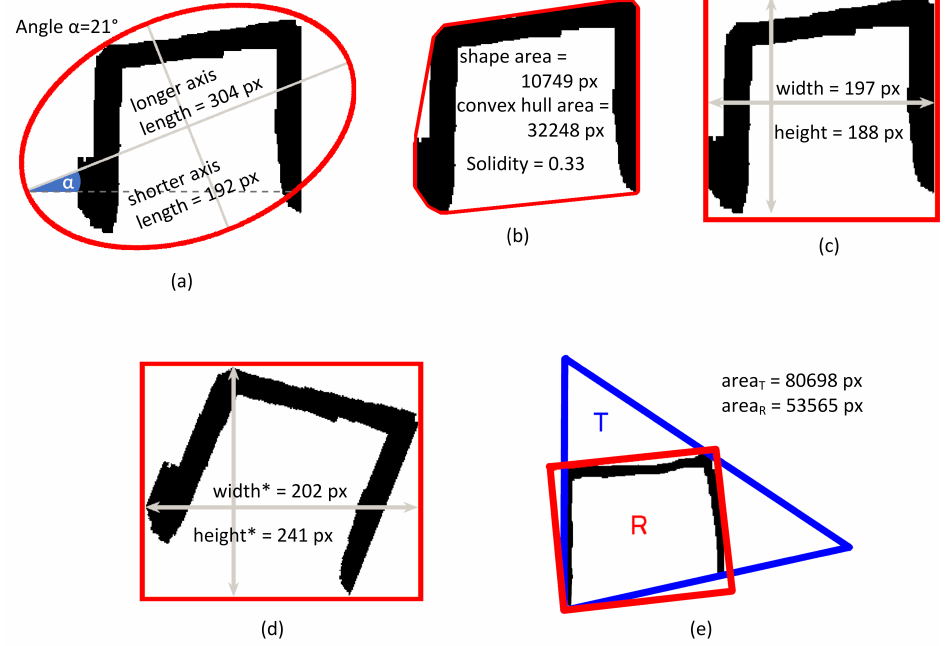
Figure A1. ( a ) ellipse with the same normalized second central moment as extracted character (rectangle); ( b ) character and its convex hull (red); ( c ) width and height of the character as width and height of the bounding box (red), ( d ) width and height of the character after rotation, ( e ) smallest triangle T and rectangle R circumscribing a character. In images lowercase-names mark features that will be normalized to the first (template) shape in